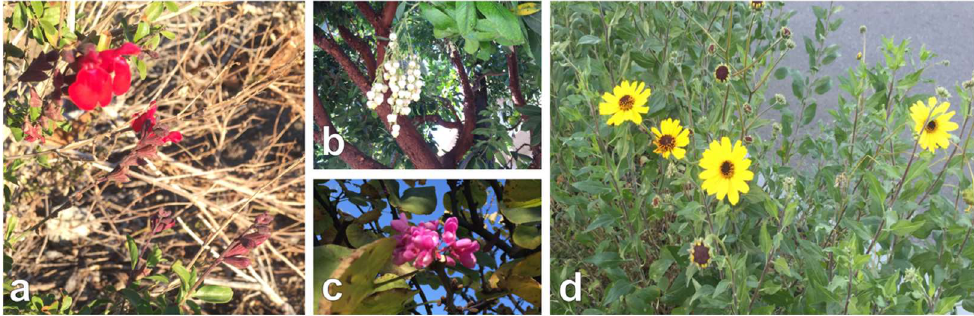
Figure 6. Flowering plants that could provide pollination services observed in bioretention systems at: ( a ) Elmer Avenue, ( b ) Bicknell Avenue, ( c ) Grand Boulevard, and ( d ) Los Angeles Zoo. Pollination services are typically seen as an input to the agricultural process, with